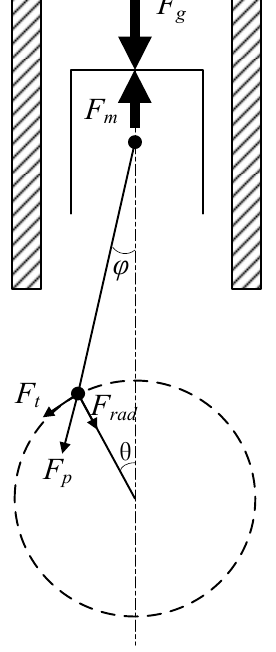
Figure 4. Schematic diagram of forces on components of the crank-piston system.